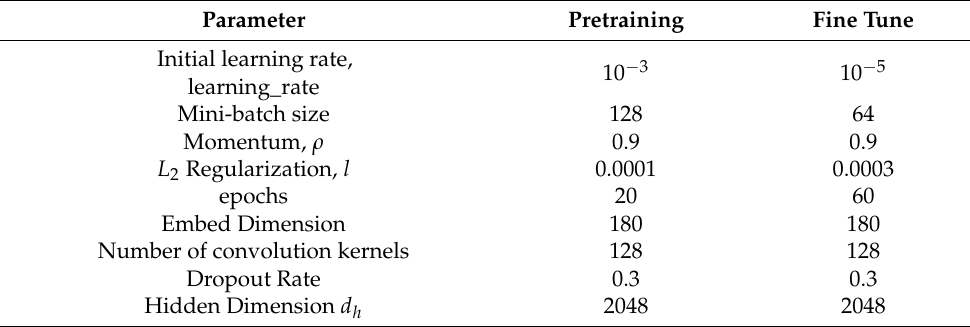
Table 4. List of parameter values used in the NN pretraining and SCVDIE-Ensemble. Parameter Pretraining Fine Tune Initial learning rate, 10 − 3 10 − 5 learning_rate Mini-batch size 128 64 Momentum,